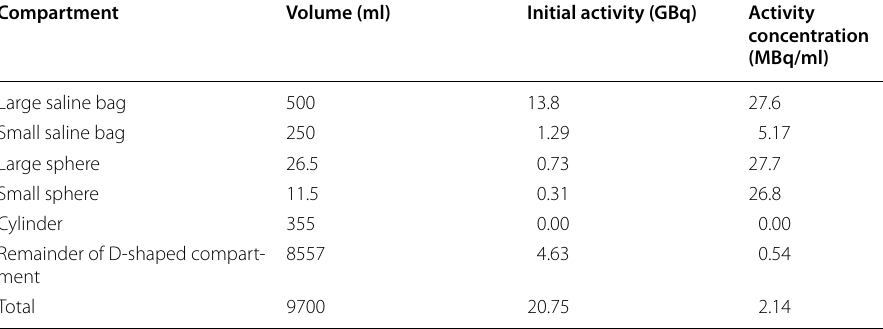
Table 1 NEMA phantom initial 177 Lu activity distribution